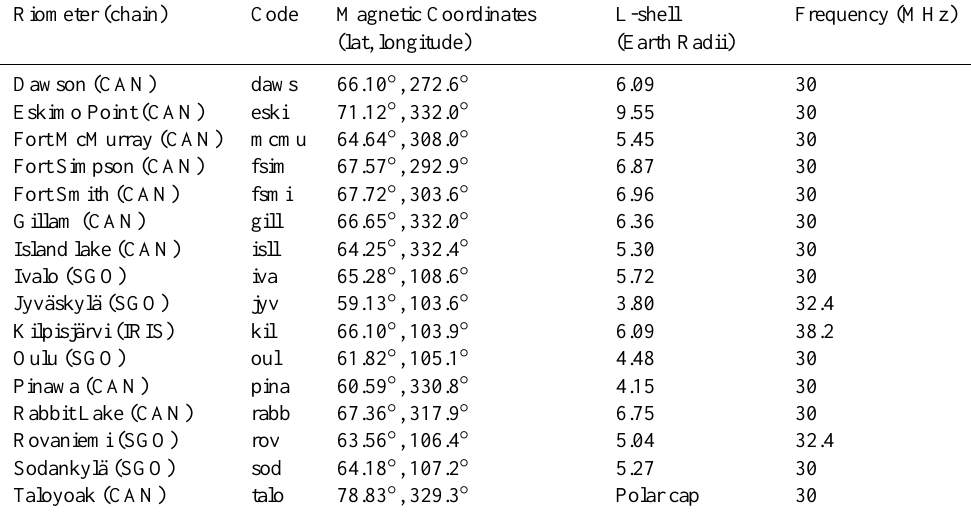
Fig. 1. (a) Positions of the ground stations used in this study. The size of the circles represents approximate fields of view at 90km altitude. (b) Orbital positions of the satellites at the magnetospheric equatorial plane, also shown are the projected positions of the SGO and Churchill line riometers using the IGRF model. Taloyaok is not plotted since the riometer is inside the polar cap and exposed to open field lines. Table 1. List of riometers used in this study. Columns from left to right represent: the instrument name and the chain it belongs to (e.g. CAN=CANOPUS) instrument code, the magnetic coordinates (latitude and longitude), L shell and the operating frequency. All instruments are in the Northern